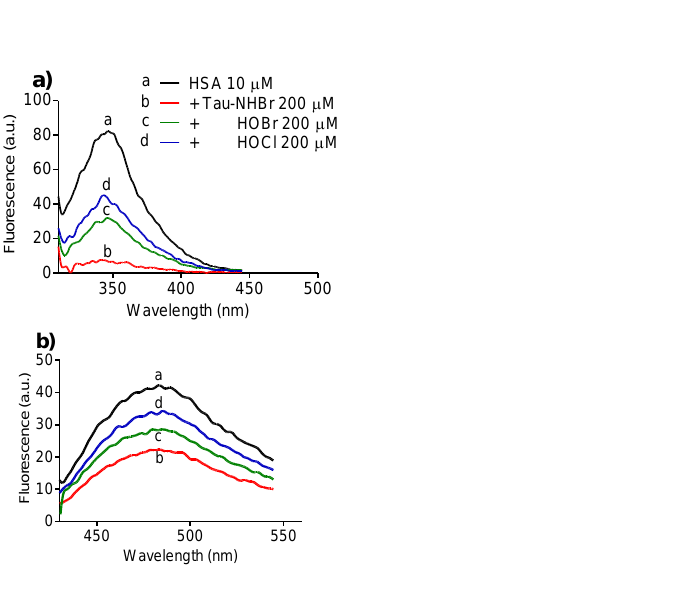
Figure 6. Oxidation of HSA by HOBr, HOCl and Tau-NHBr. ( a ) Reaction mixtures were composed of 10 µM HSA and 200 µM oxidants in 5.0 mM phosphate buffer, pH 7.0. After five minutes, 250 mM methionine was added and the HSA intrinsic fluorescence was measured at an excitation of 295 nm; ( b ) Addition of 5 µM dansylglycine to the oxidized protein and its fluorescence obtained by energy transfer from tryptophan residues.